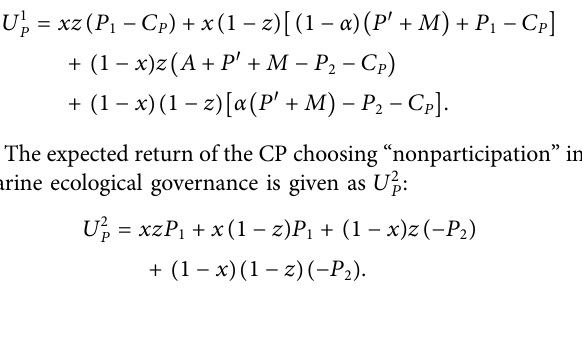
Frontiers in Environmental Science |